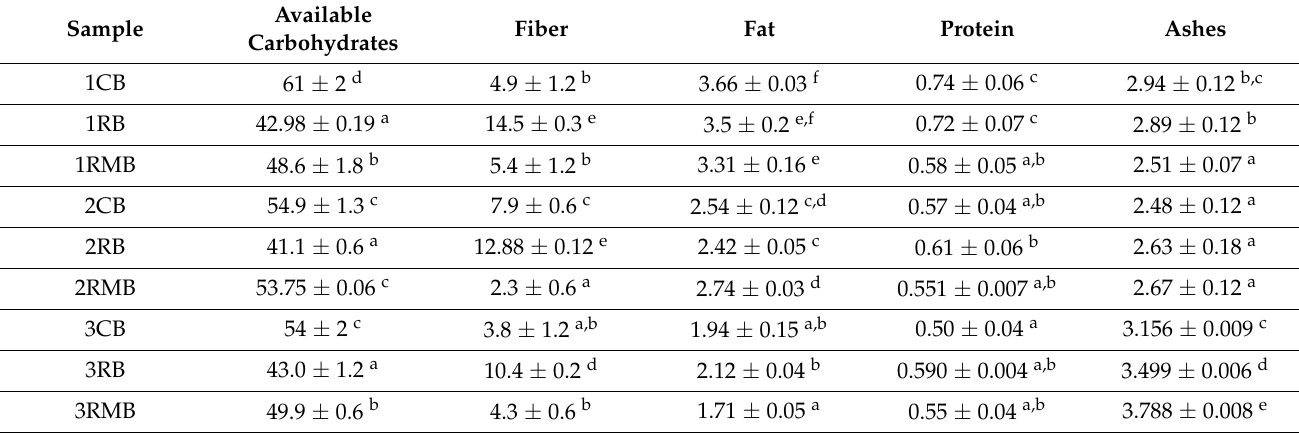
Table 5. Centesimal composition of the different samples expressed in g/100 g